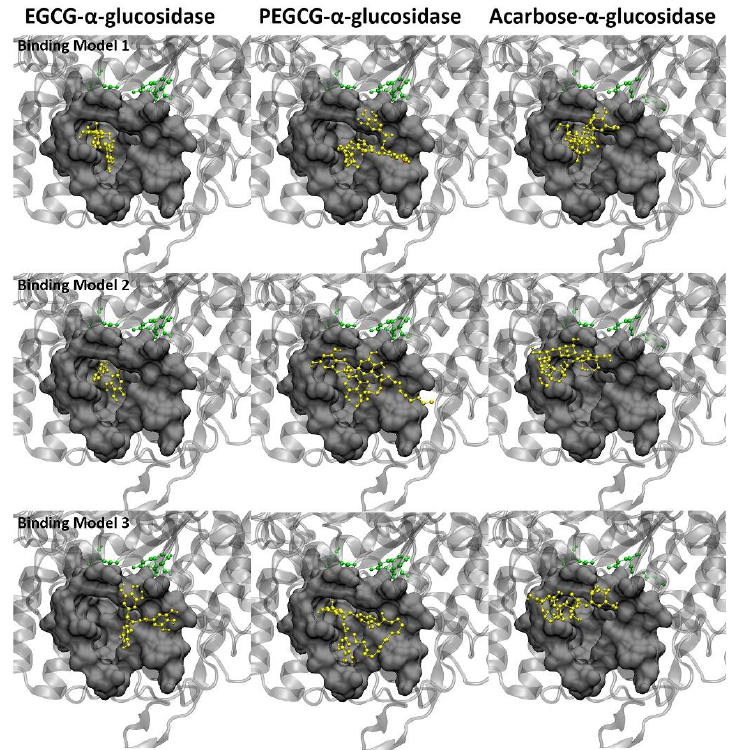
Figure 5. Top 3 predicted binding models of the ligands with α-glucosidase. Protein is shown in silver in the cartoon model. Drugs are shown in yellow. The catalytic sites are displayed in green. The ligand molecules are represented in yellow. Amino acids in contact are displayed in the surface model. The red and blue dotted lines stand for hydrogen bonds.